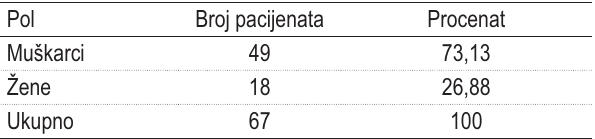
TABELA 1. Polna struktura pacijenata ukljuwenih u istraživanje